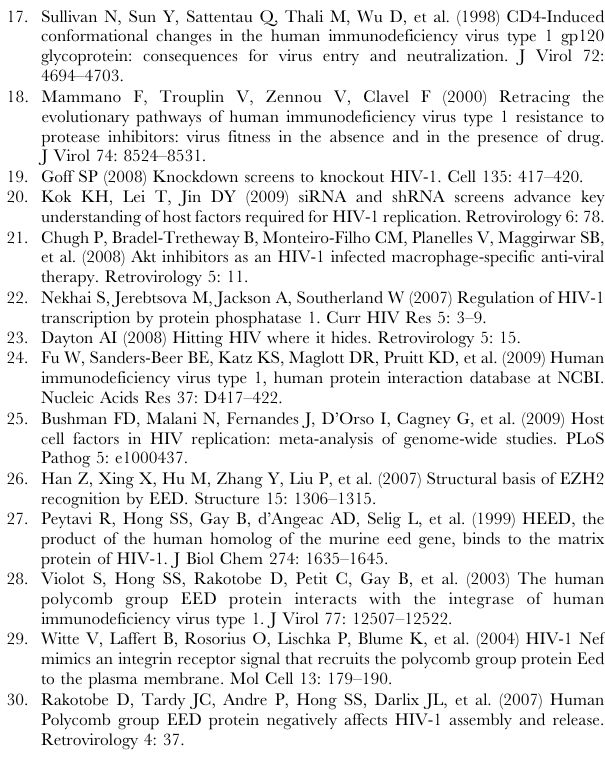
Table S4 Canonical Pathways involving identified genes. Representation of the different canonical pathways where the genes identified in this study can play a role. The representative- ness of each pathway in our study population and the ratio of our genes in the canonical pathway were calculated by IPA-Ingenuity Systems